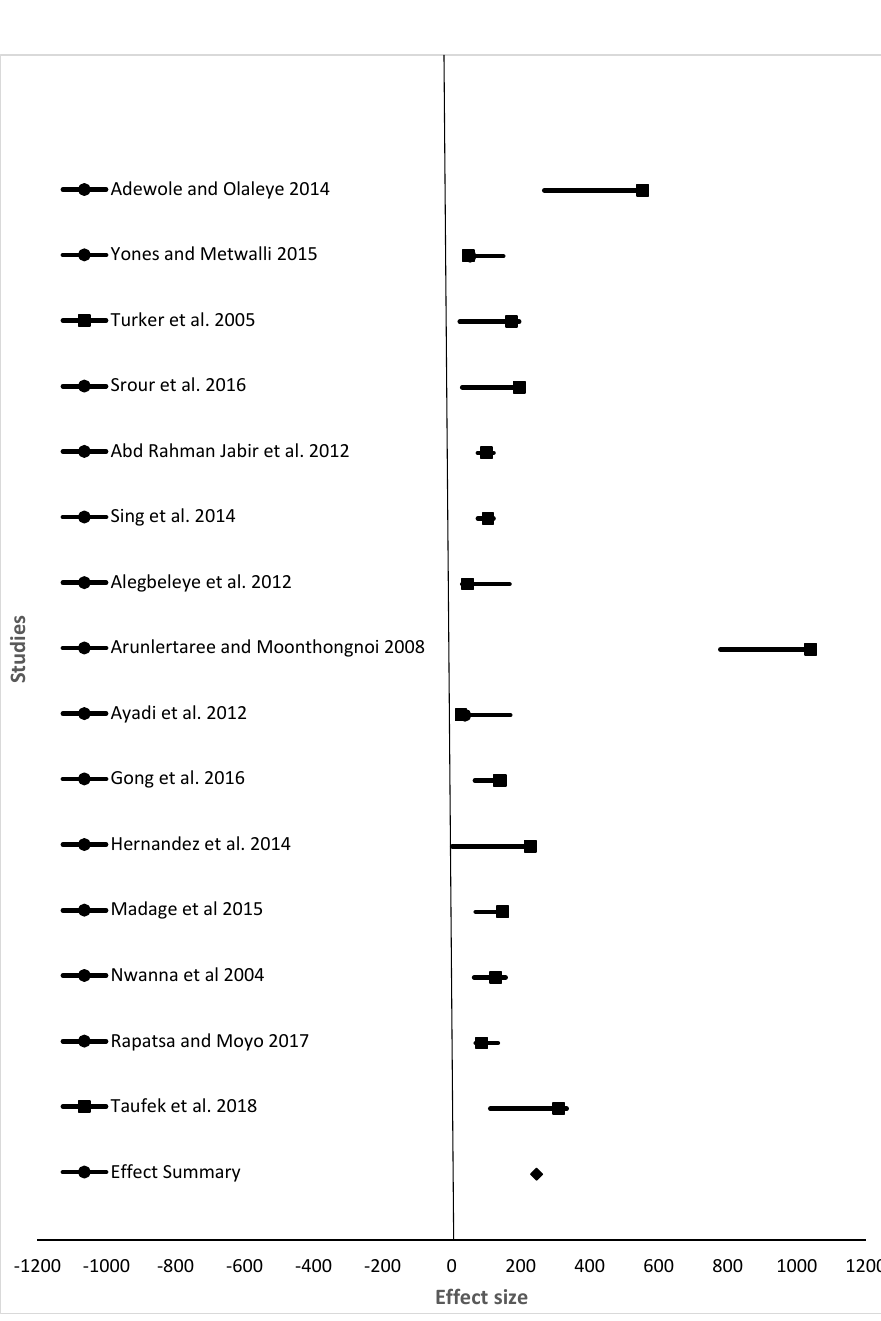
Figure 2. The effect size of final weight (%) of fish from different studies fed different animal protein sources compared to fishmeal as a protein source.